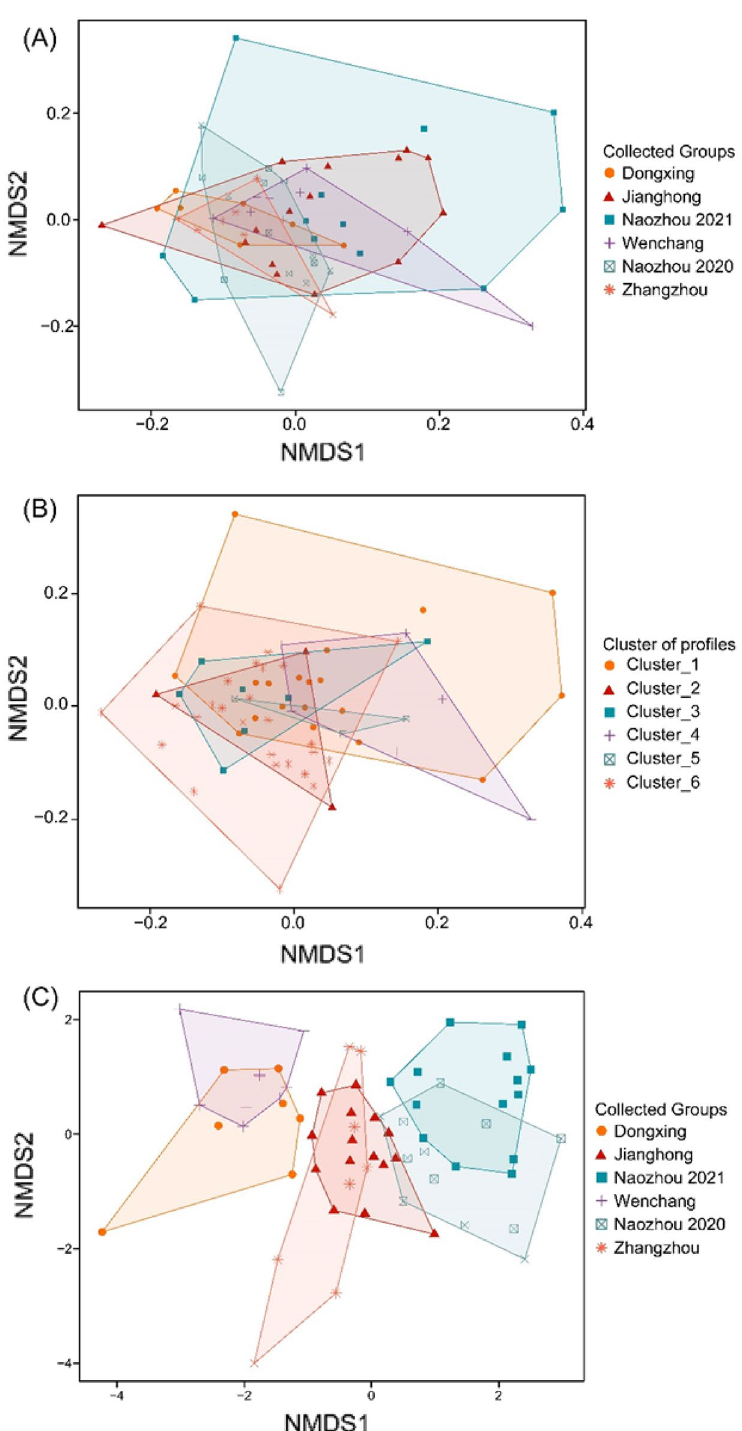
Figure 7. Relationships between fourfinger threadfin individual using nonmetric multidimensional scaling. For otolith core element signals, sampling locations and cluster of profiles were respectively identified by colored shapes in ( A ) and ( B ), and for otolith edge element signals, sampling locations were identified by colored shapes in ( C